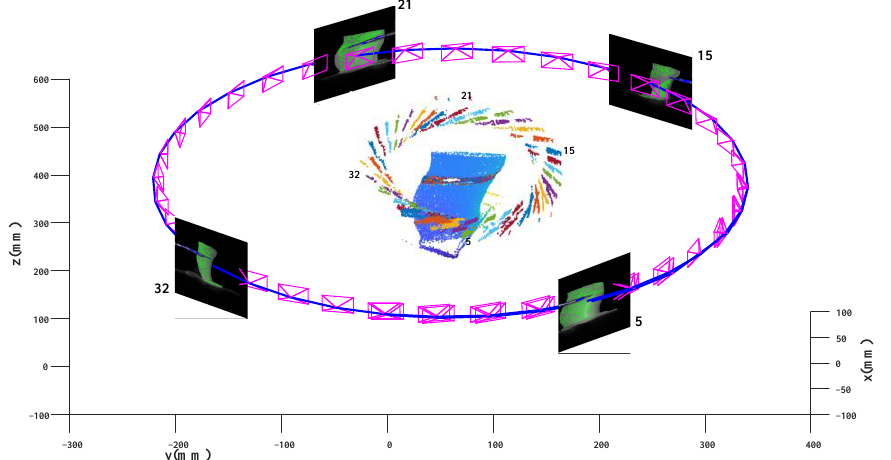
Figure 5. The output of our pipeline. (1) The trajectory of the camera is represented by the blue line. The magenta pyramid denotes the pose of each frame. For a clearer presentation, the images show the pictures captured by the camera at frames 5, 15, 21, and 32. In each image, the green and blue marks mean the tracked feature points on the target object and moving tool, respectively. (2) 3D model. The blue point cloud in the center of the figure is the 3D model of 𝑊 𝑎 , surrounded by the moving tool. Here, different colors show the tool observed in each frame. With the rotation of the camera and the movement of the tool, the occluded parts will be observed and modeled in other frames, as shown in the middle of the 3D model with different colors. Here, different colors represent that the occluded parts of other frames are observed in the current frame.